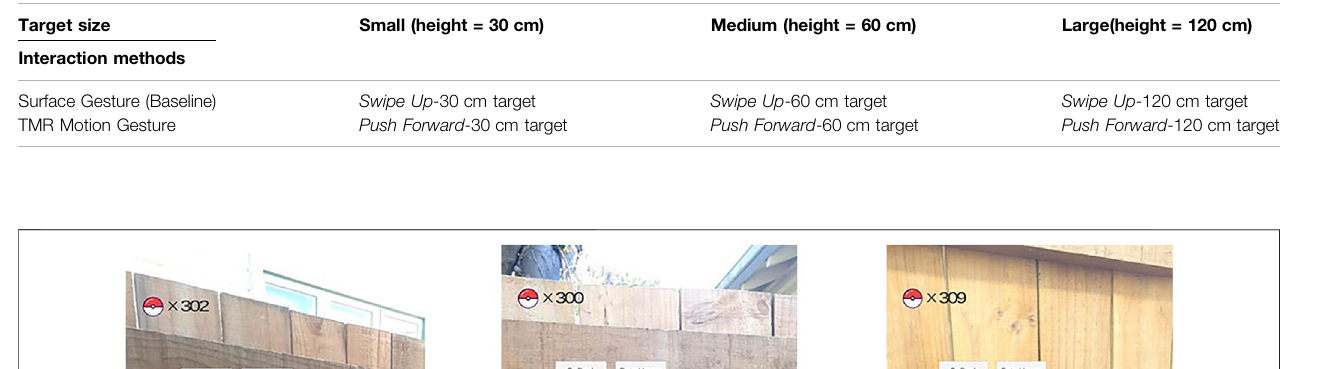
participants preferred the baseline Surface gesture, while the other half chose the TMR motion gesture, as shown in Figure 11B . Those who preferred the Surface gesture found it easier to use, while those who liked TMR motion gesture found it more challenging and felt more engaged in the game.